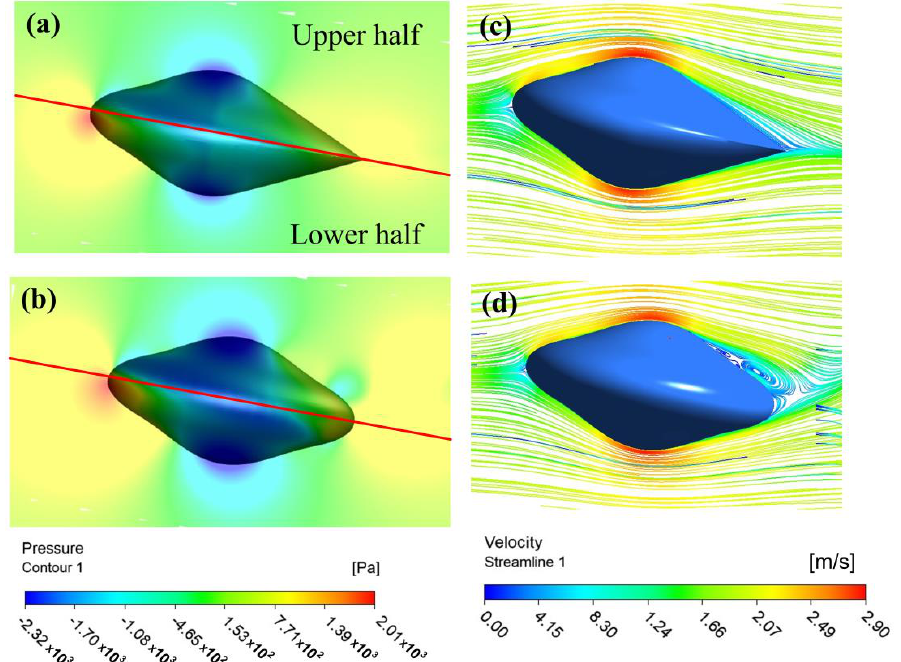
Figure 8. Pressure distribution and streamlines of AUH in 𝑥𝑜𝑧 plane at a velocity of 2 m/s and an AOA of 10 degrees ( a , c ) for HG3 ( b , d ) for HG1. With a horizontal motion velocity of 2 m/s and an AOA of 10 degrees, the pressure distribution of in the 𝑥𝑜𝑧 plane is shown in Figure 8a,b. At the heading part of the AUH hulls, the hydrodynamic pressure in the lower half is greater than that in the upper half, which is the origin of the lift, and the pressure contour is similar for the two hulls. At the rear part, it can be found that the pressure distribution of HG3 is smoother than that of HG1. As shown in Figure 8c, d, the vortex area with motion appears in the upper position of the tail, and the vortex area is significantly larger than that with a pure surge motion with zero AOA. It shows that when HG1 moves at the angle of attack, its hydrodynamic force and moment affect its stability more clearly. Accordingly, the temporal evolution of drag, lift, and overturning moment ( 𝑀 𝑦 ) at a velocity of 2 m/s and an AOA of 10 degrees is shown in Figure 9. The time-averaged drag resistance and time-averaged overturning moment of HG3 are reduced by 27.5% and 38.4%, respectively, compared to HG1, which reduces the energy consumption of the AUH, and the reduction in the overturning mo- ment can reduce the difficulty in motion control. The time-averaged lift of HG3 is 431.1